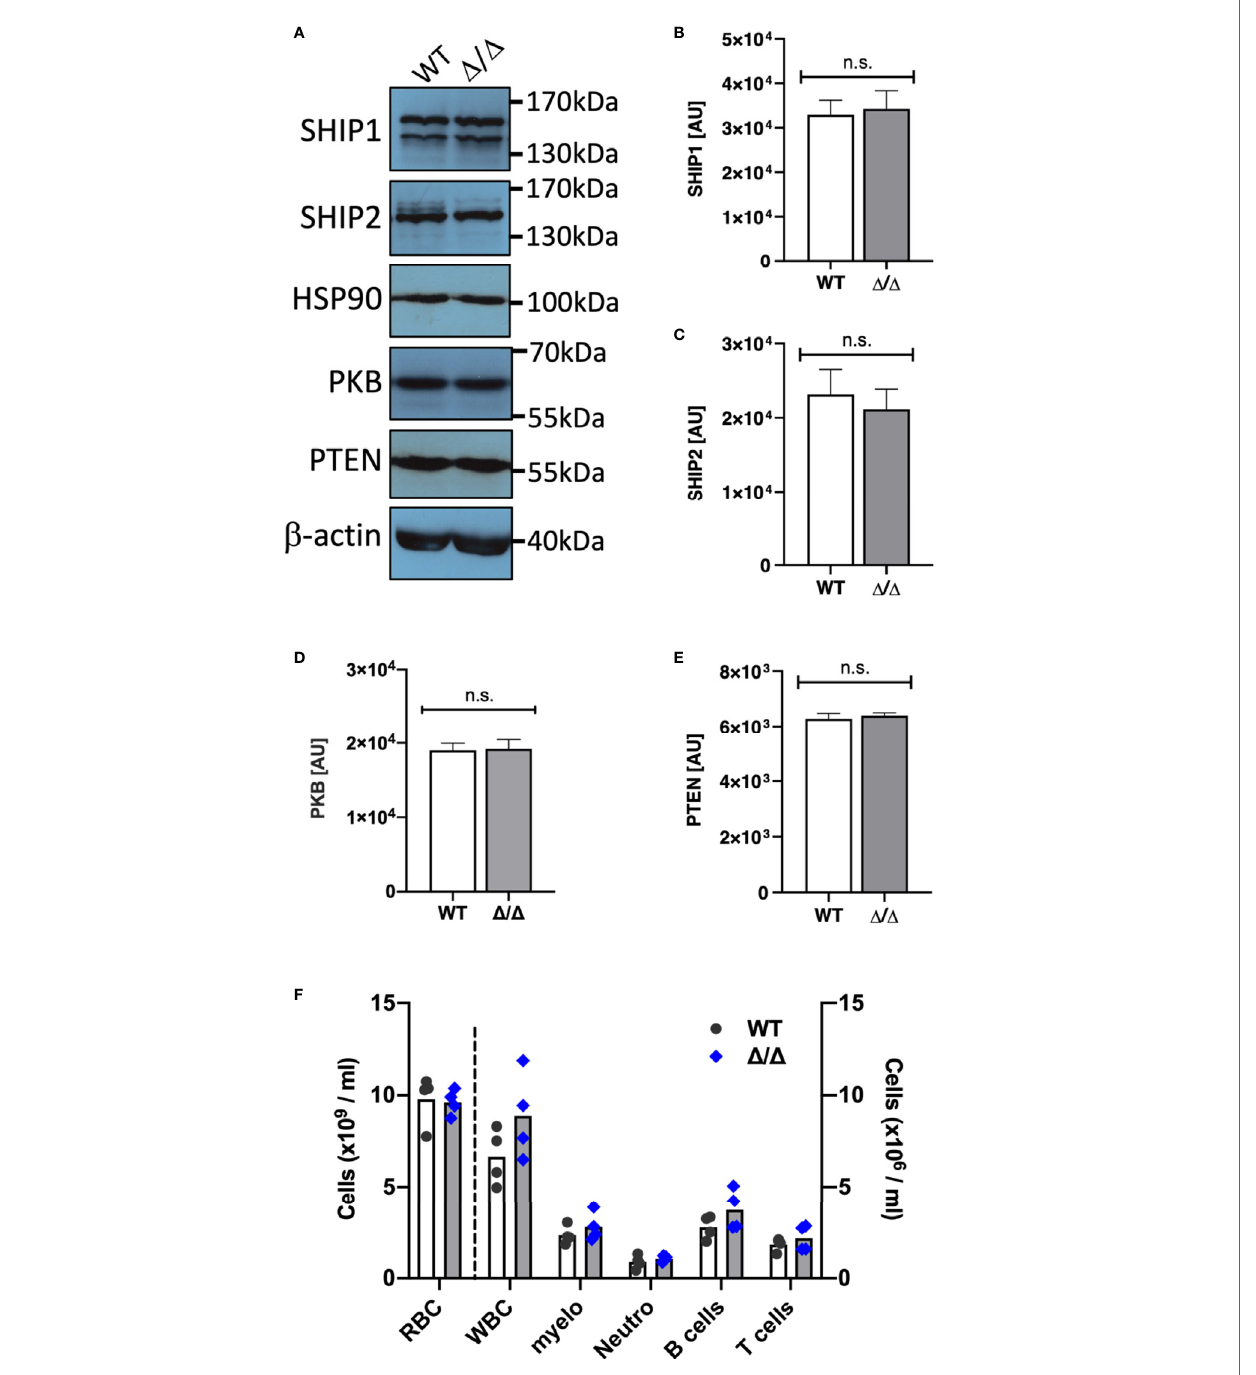
FIGURE 1 | SHIP1/2 and PTEN expression is not affected in Ship2 D / D mice. Neutrophils from wild-type (WT) and Ship2 D / D ( D / D ) mice were tested for SHIP1, SHIP2, PTEN, PKB and loading control (HSP90, b -actin) expression. (A) Representative examples and (B – E) densitometry of 4 (PTEN, PKB, HSP90) or 5 (SHIP1/2, b -actin) separate experiments performed. Mean ± SEM are presented; AU, arbitrary units. n.s., not signi fi cant. (F) A comparison of blood cell counts between wild-type and Ship2 D / D mice. RBC, red blood cells; WBC, white blood cells; myelo, myeloid cells; neutro, neutrophils. Every symbol represents data obtained from one mouse. p values were determined by unpaired two-tailed t tests; differences did not reach signi fi